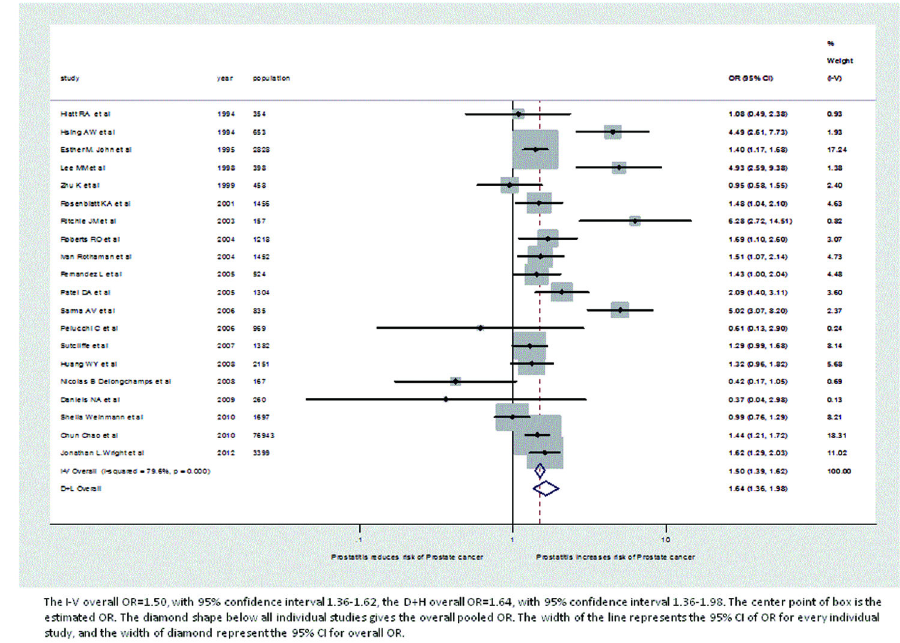
Figure 2. Forest plot of odds ratio under fixed effect and random effects model.